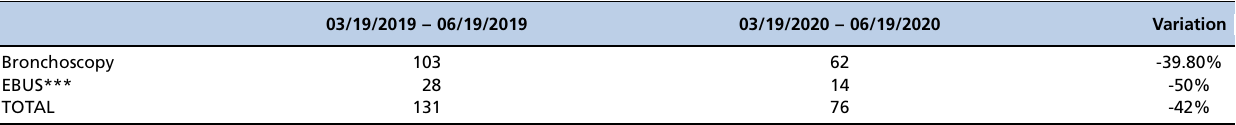
Table 2b - Respiratory endoscopic procedures performed and variations between the two time periods.